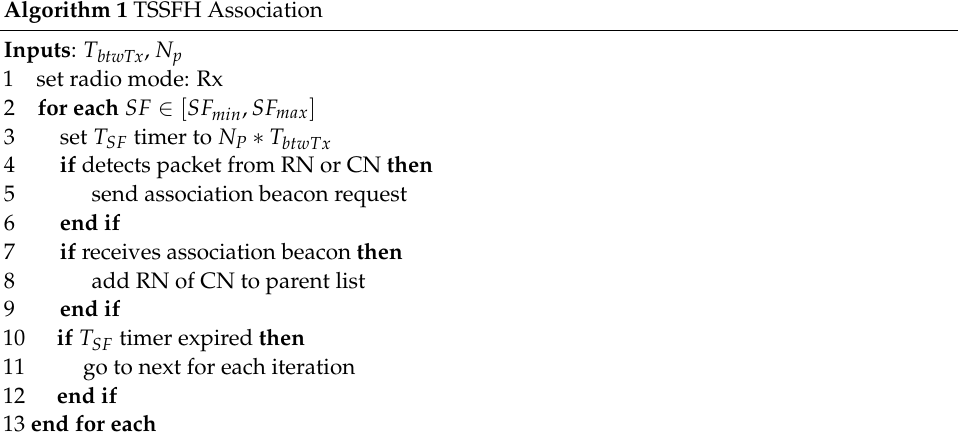
Algorithm 1 TSSFH Association